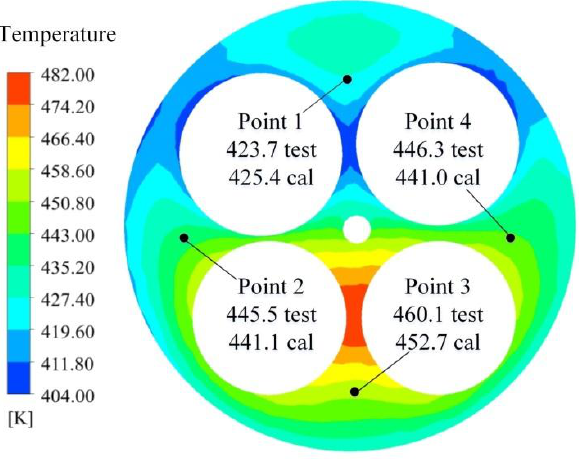
Figure 6. Temperature distribution of fire surface.